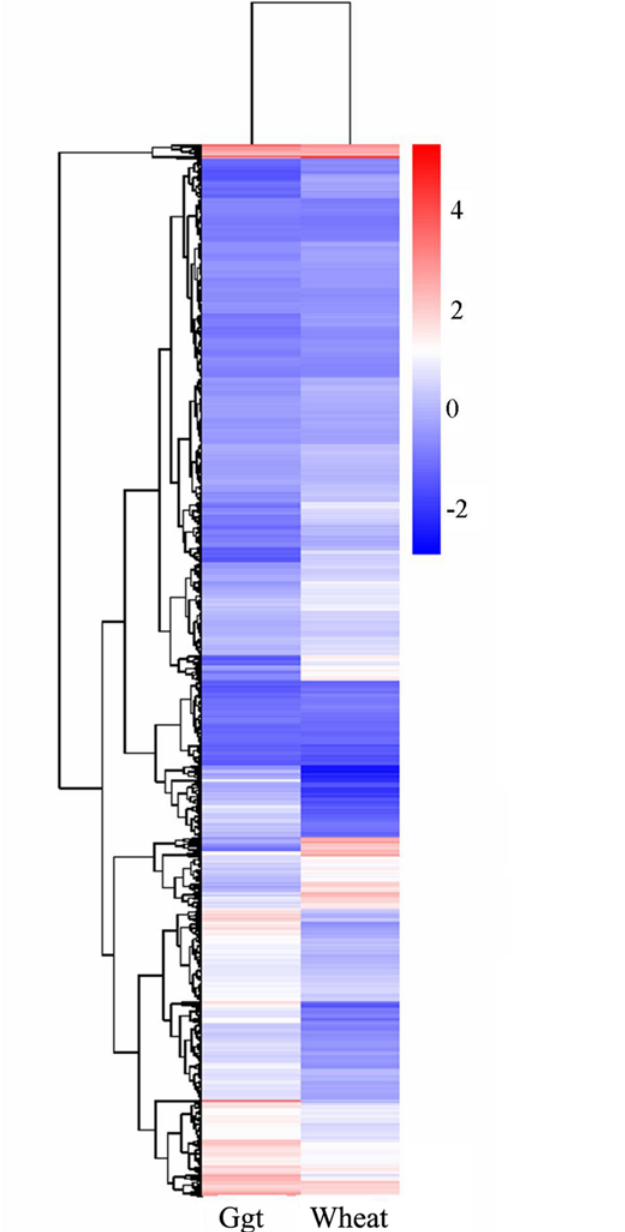
Fig 2. Hierarchical clustering analyses of DEGs. According to the two sample ’ s log10 (RPKM+1), red indicates high expression of the gene, blue indicates low expression of genes. Ggt: Ggt -cultures, Wheat: Ggt - infected wheat